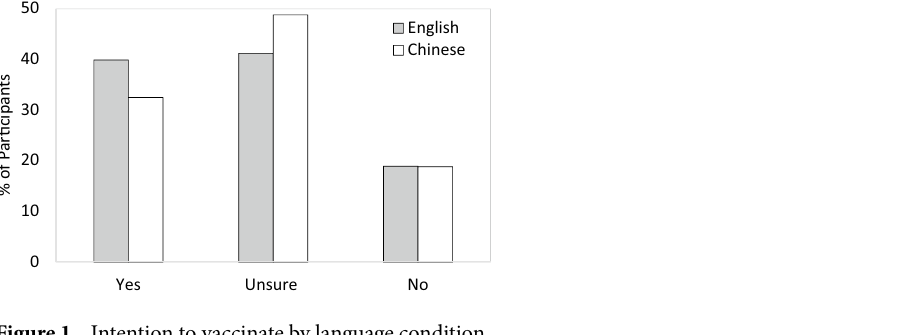
Figure 1. Intention to vaccinate by language